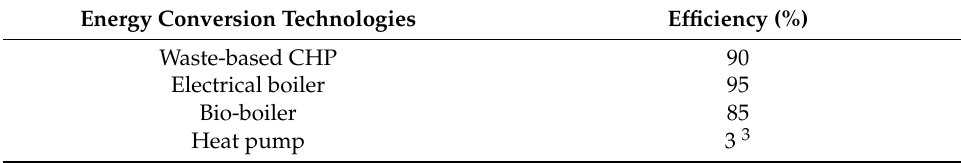
Table 6. Energy efficiency values of the considered energy conversion technologies.